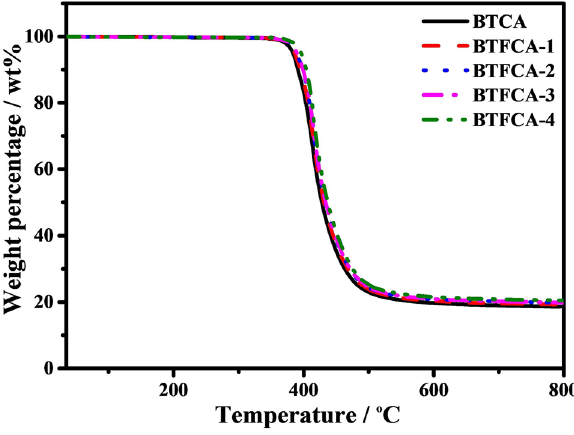
Fig. 6 TGA curves of BTCA/epoxy and BTFCA/epoxy nanocom-